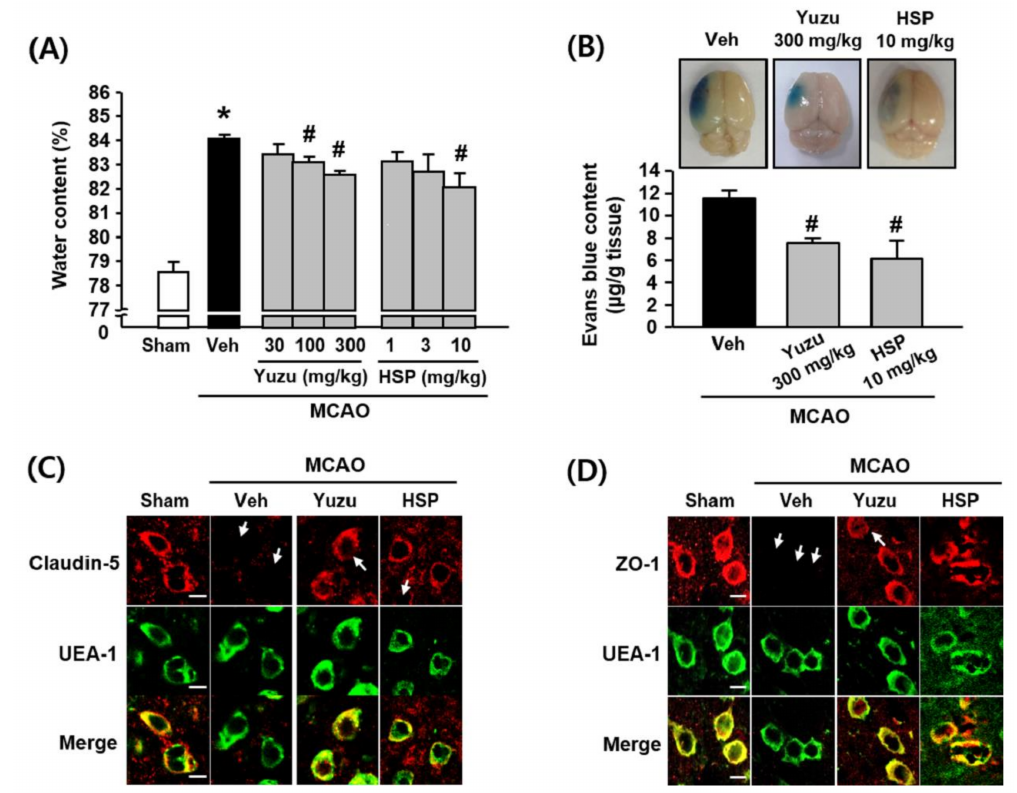
Figure 1. E ff ects of yuzu and hSP on water content and BBB (Blood-Brain Barrier) dysfunction in a mouse MCAO model. ( A ) Quantitative analysis of water content in brain tissues. Water content was measured 24 h after MCAO in ischemic hemispheres. All mice were intravenously treated with yuzu (30, 100 or 300 mg / kg) or hSP (1, 3, or 10 mg / kg) 30 min before MCAO. Data are shown as mean ± SEM. ( n = 5–7). ( B ) Top, representative photographs of the whole brain. Evans blue extravasation was observed in the ischemic hemispheres as blue areas in the whole left brain. Bottom, quantitative analysis of Evans blue content in brain tissues. Data are shown as mean ± SEM ( n ≥ 5). * p < 0.05 vs. sham, # p < 0.05 vs. Veh. ( C , D ) Representative fluorescence images of ( C ) ZO-1